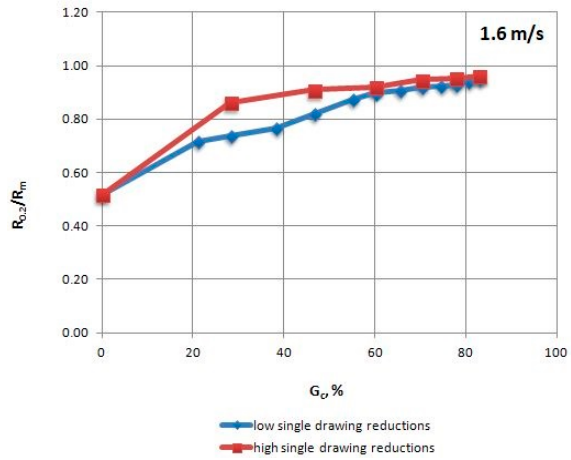
Figure 4. Change of the R 0.2 / R m coe ffi cient of TRIP steel wires for variants with low and high single drawing reductions, at a speed of 1.6 m / s, as the total drawing reduction function.